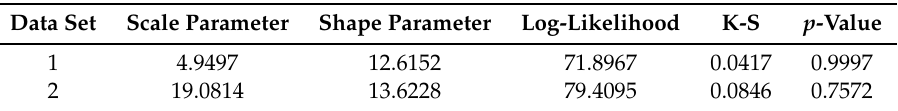
Table 7. Scale parameter, shape parameter, log-likelihood, K-S distances and p -values of the fitted inverse Weibull models to Data Sets 1 and 2.